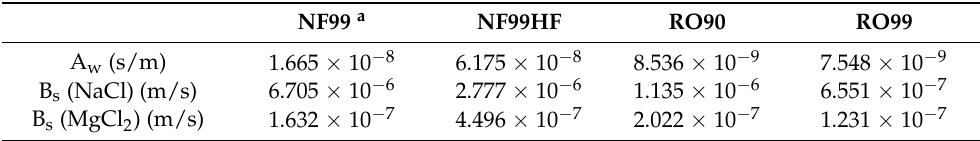
Table 3. Physicochemical properties of the emerging pollutants studied. Table 2. Characterization of the different membranes. Experimental values for solvent permeability